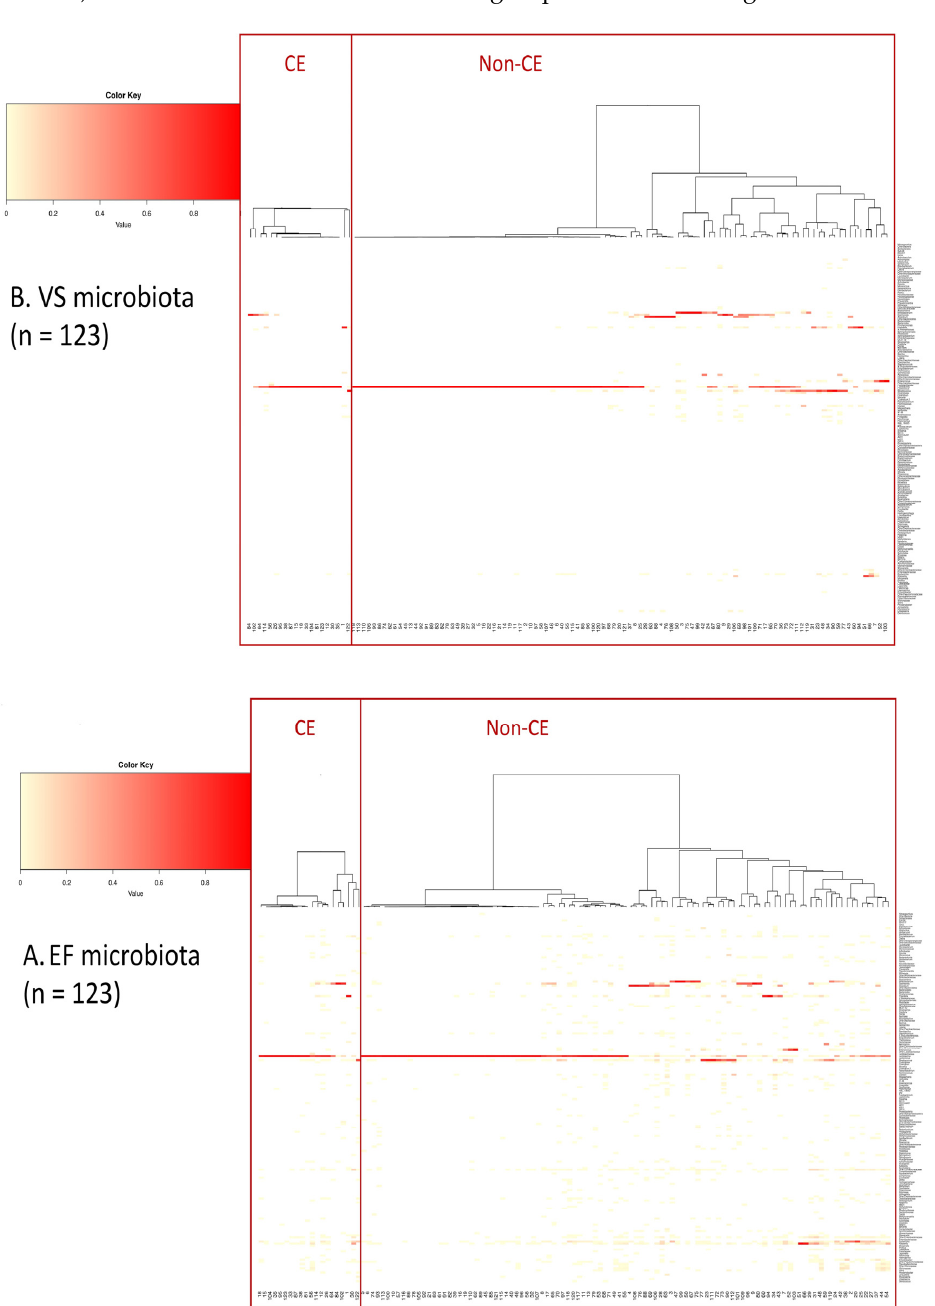
Figure 2. Heatmap diagrams representing dominant bacterial genera (with a total rate 0.1% or more) found in the EF ( A ) and VS ( B ) in the CE and non-CE groups. While the rows show bacterial genera, the columns represent the subject